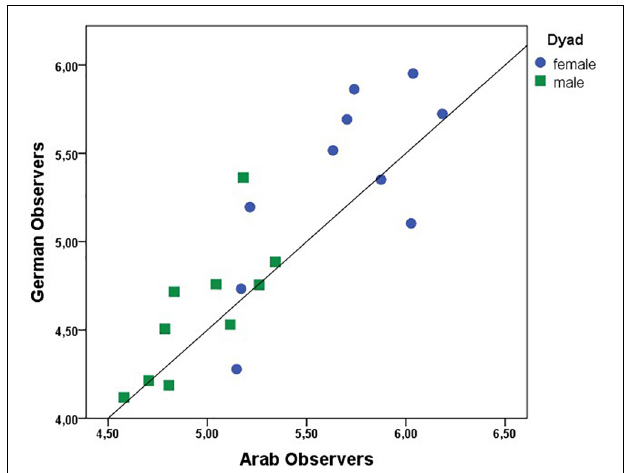
FIGURE 3 | Correlation graph for German and Arab observers, differentiated for male (green squares) and female (blue circles) stimulus dyads.